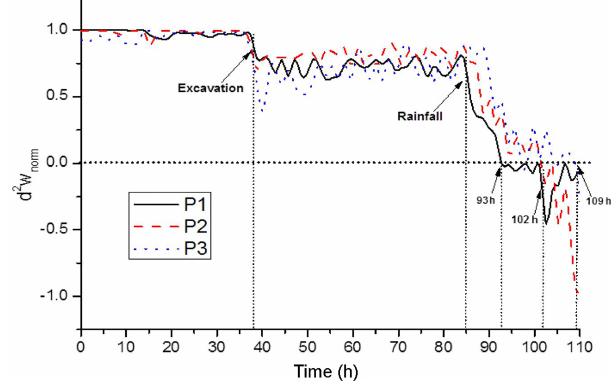
Figure 15. Evolution of normalized local second-order work with